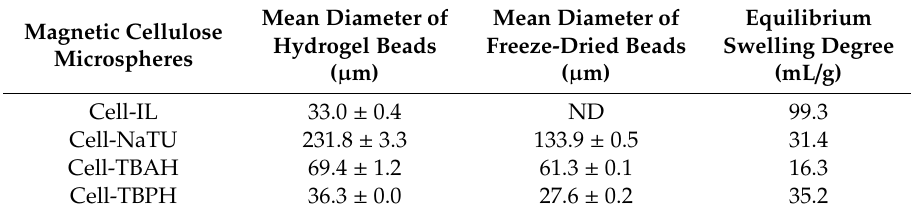
Figure 4. Size distribution of the magnetic cellulose microbeads before (solid line) and after (dashed line) freeze-drying. ( a ) Cell-IL, ( b ) Cell-NaTU, ( c ) Cell-TBAH, and ( d ) Cell-TBPH. Table 3. Mean diameters and swelling degrees of magnetic cellulose